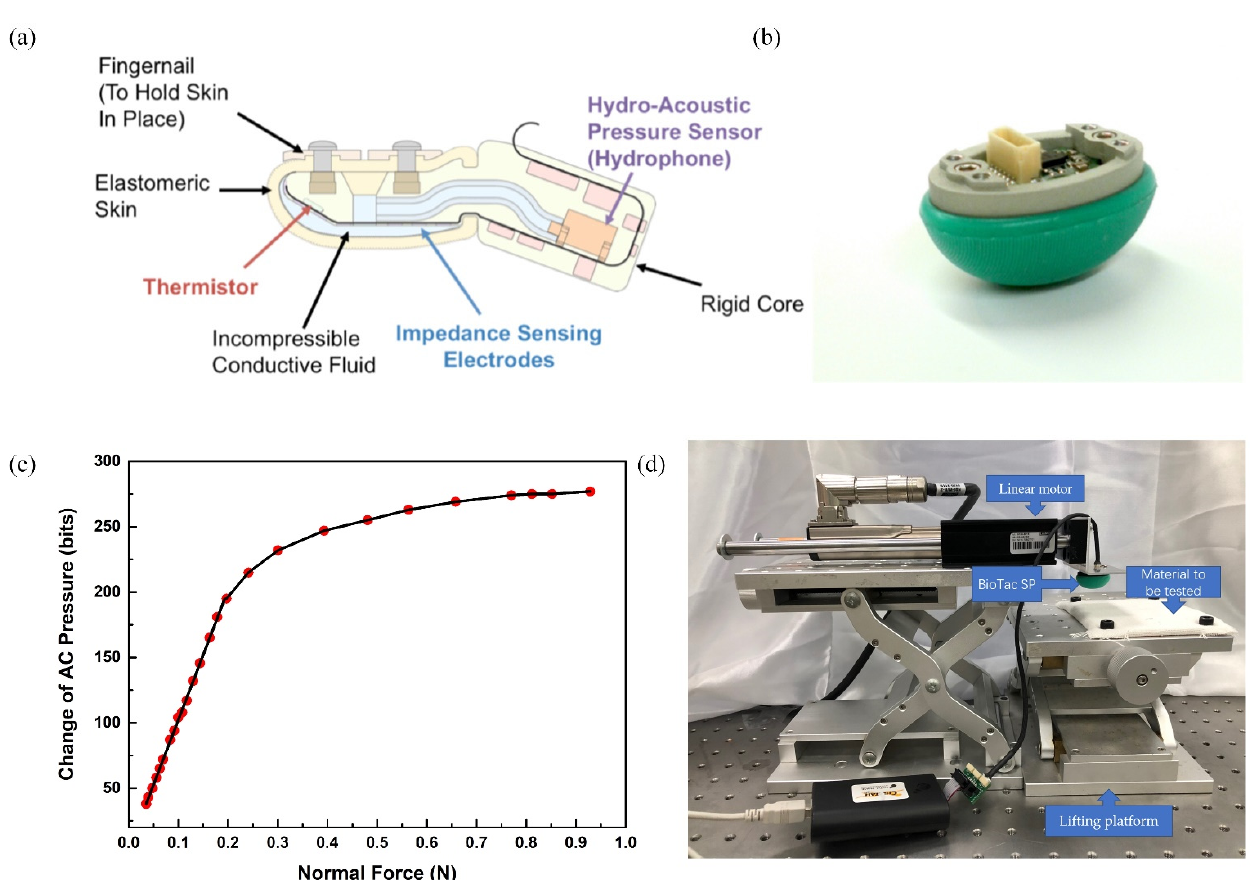
Figure 2. Experimental setup and measurement performances of the sensor: ( a ) schematic showing the structure of the original BioTac [55]; ( b ) photograph of BioTac SP sensor [55]; ( c ) the relationship between the change of AC pressure (bits) and applied normal force (N); ( d ) photograph of the experiment setup.